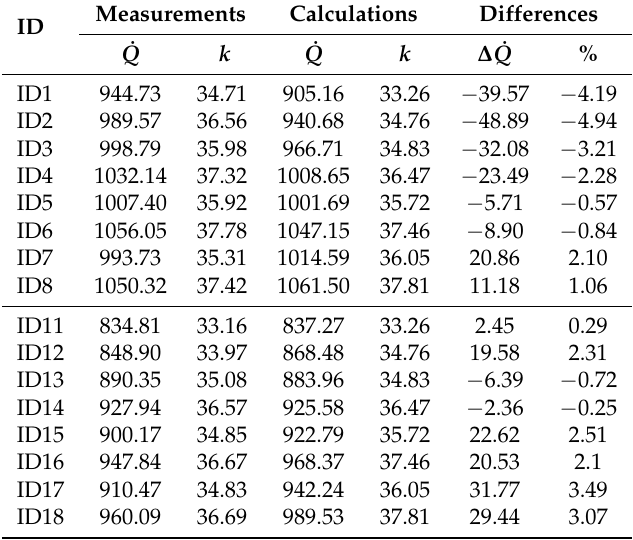
Table 10. Comparison of measurements and analytical calculations with the modified correlation. Measurements ID